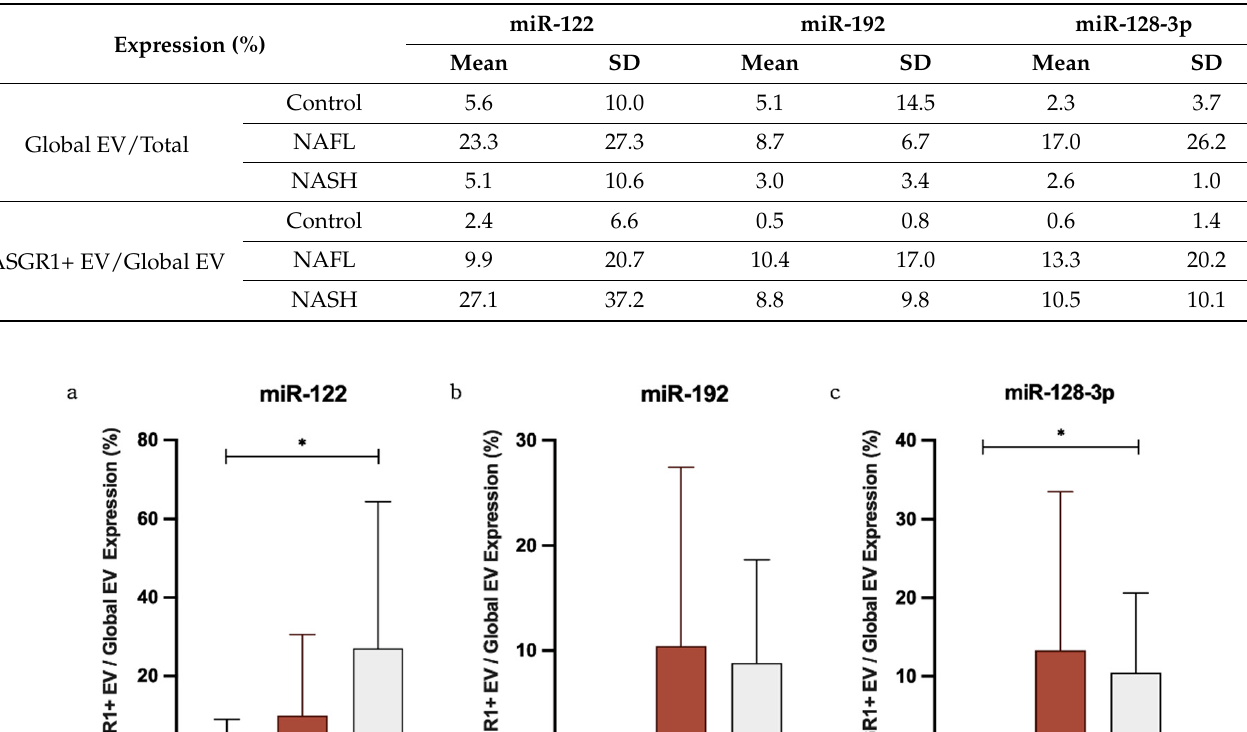
Table 3. Expression of miRNA biomarkers in global EVs as a percentage of total circulating RNA and in asialoglycoprotein receptor 1 positive (ASGR1+) EVs as a percentage of global EVs from control, NAFL, and NASH subjects.